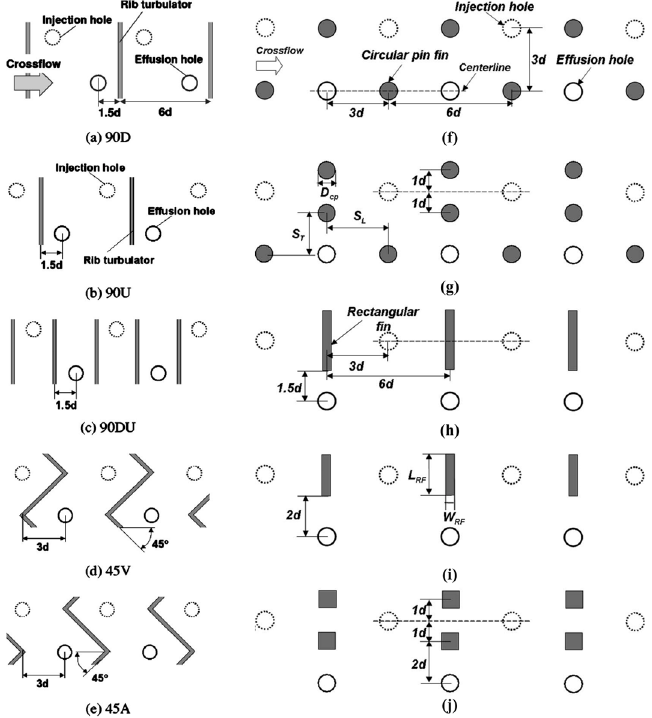
Figure 24. ( a – e ) Various rib shapes installed on the effusion plate (reprinted with permission from [111], copyright 2004 ASME) and ( f – j ) various pin shapes installed between impingement and effu- sion plates (adapted with permission from [112], copyright 2007 ASME).